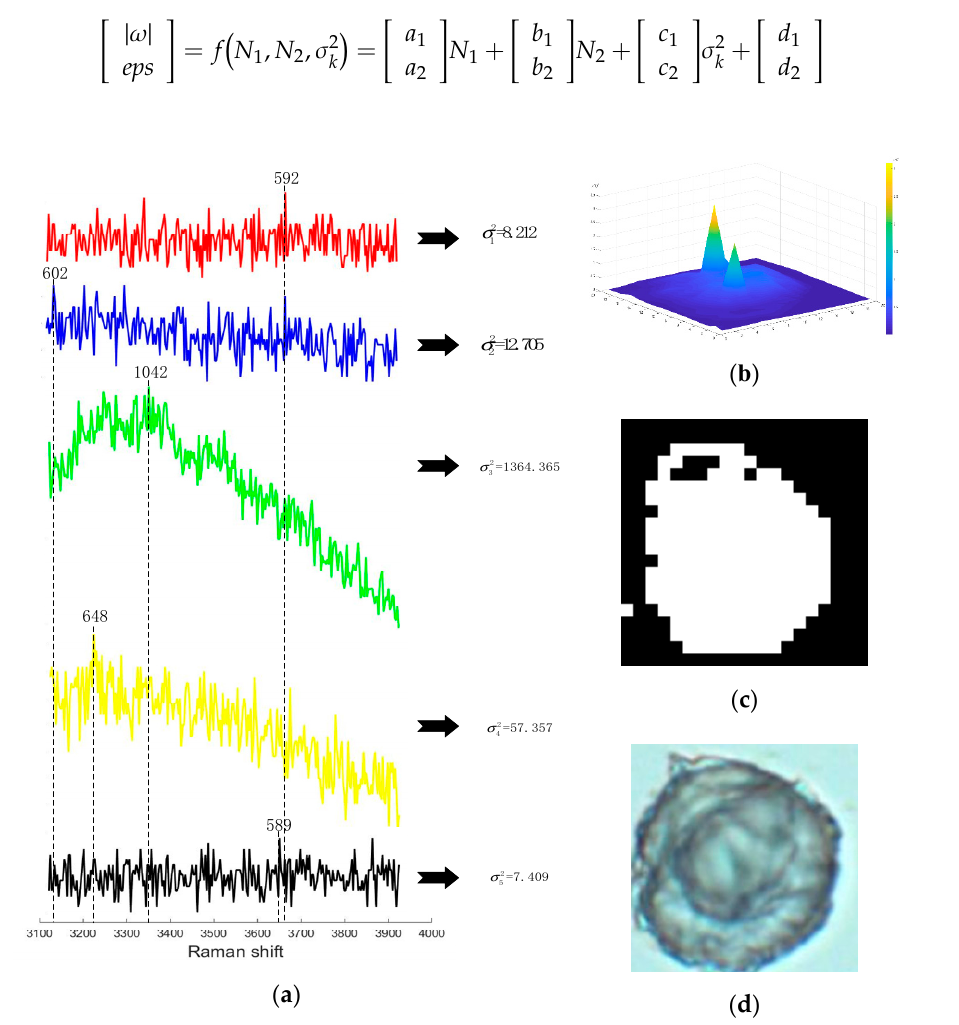
Figure 9. ( a ) Select the original Raman signal in the band. ( b ) Select the band variance depth map. ( c ) Set the binar variance graph after the threshold is 1000. ( d ) Cell image under a digital optical